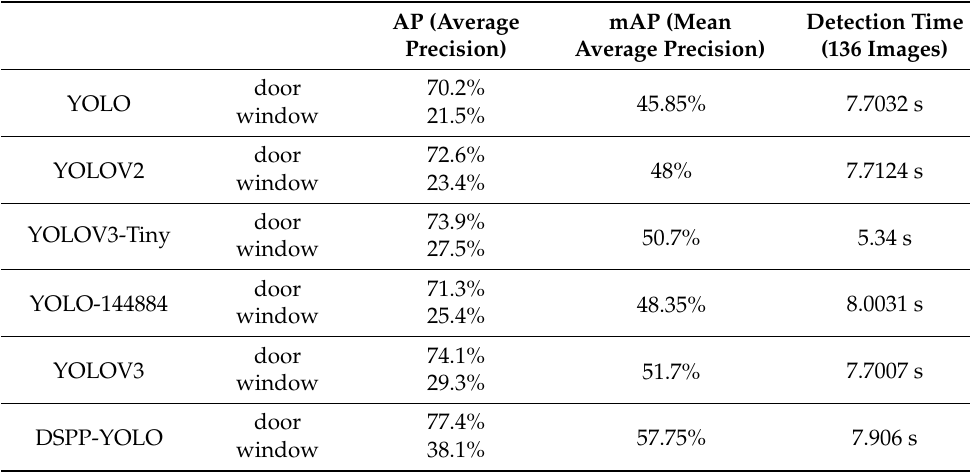
Table 3. Comparison of detection indexes between YOLOV3 and DSPP-YOLO.